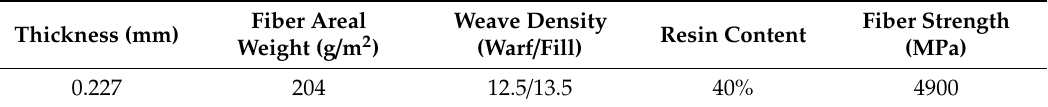
Table 1. Typical properties of carbon-fiber